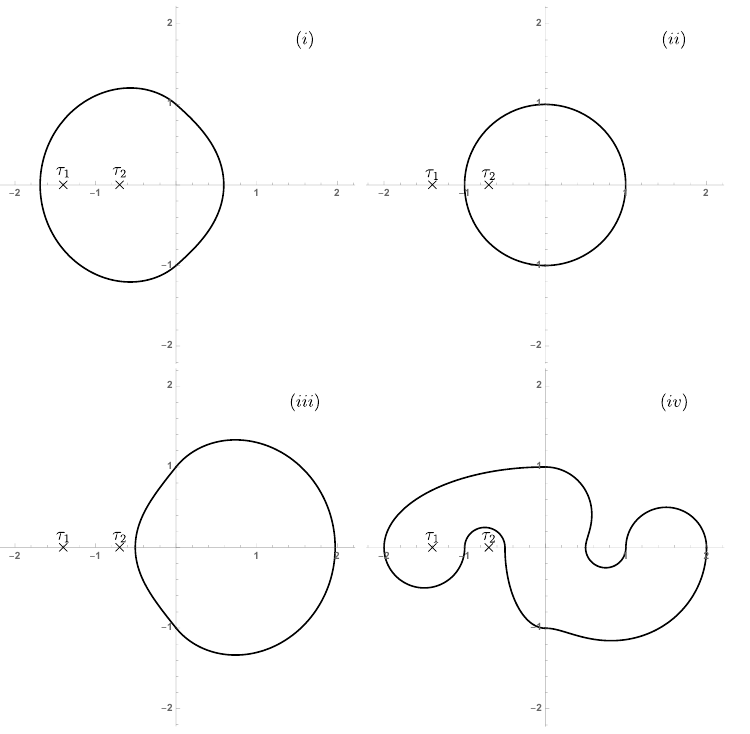
Figure 2. m < v < m : four distinct choices of (cid:0)